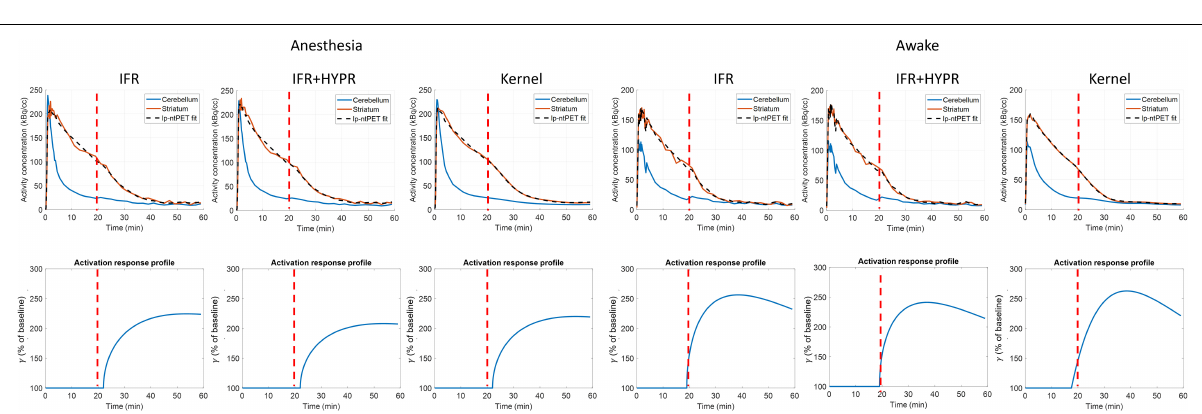
FIGURE 6 | Regional striatum and cerebellum TACs calculated from independent frame reconstruction (IFR), independent frame reconstruction with HYPR denoising (IFR+HYPR), and spatiotemporal kernel reconstructions (Kernel), in cold raclopride challenge scans of anesthetized and awake rats. Activation response profiles calculated from the lp-ntPET modeling are shown below. Cold raclopride injection at 20 min (red dotted